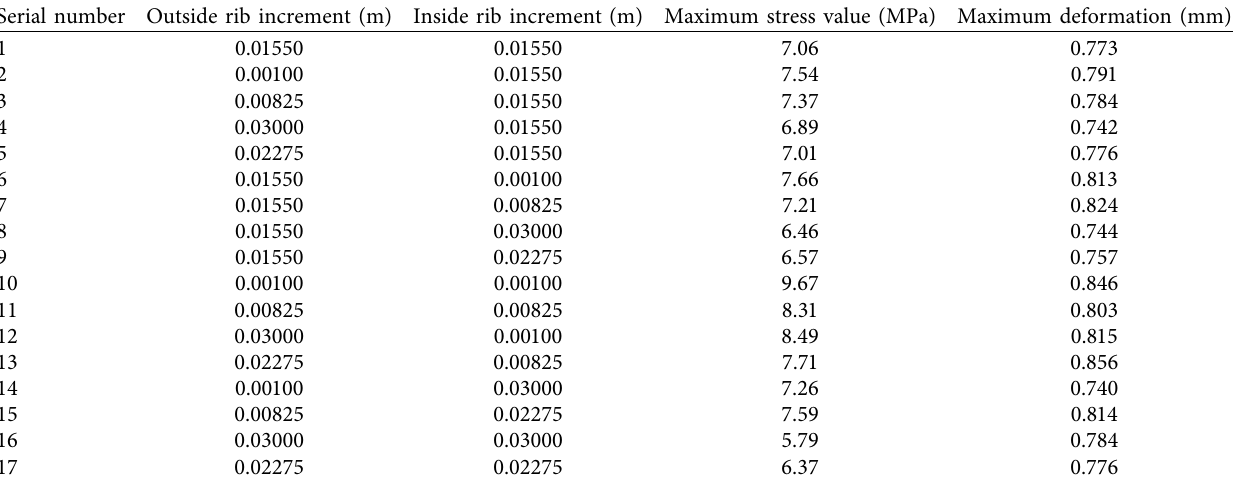
Table 3: Central composite design test point.